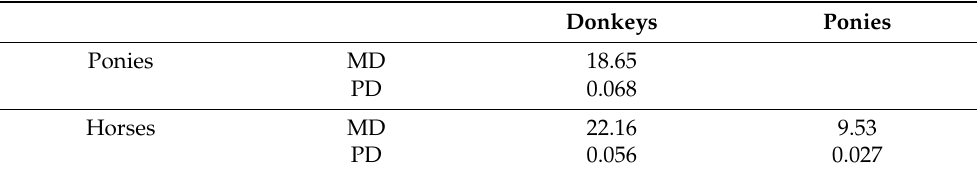
Table 2. Mahalanobis distances (MD) and Procrustes distances (PD) among the equids’ dorsal profile categories (donkeys, ponies, and horses).